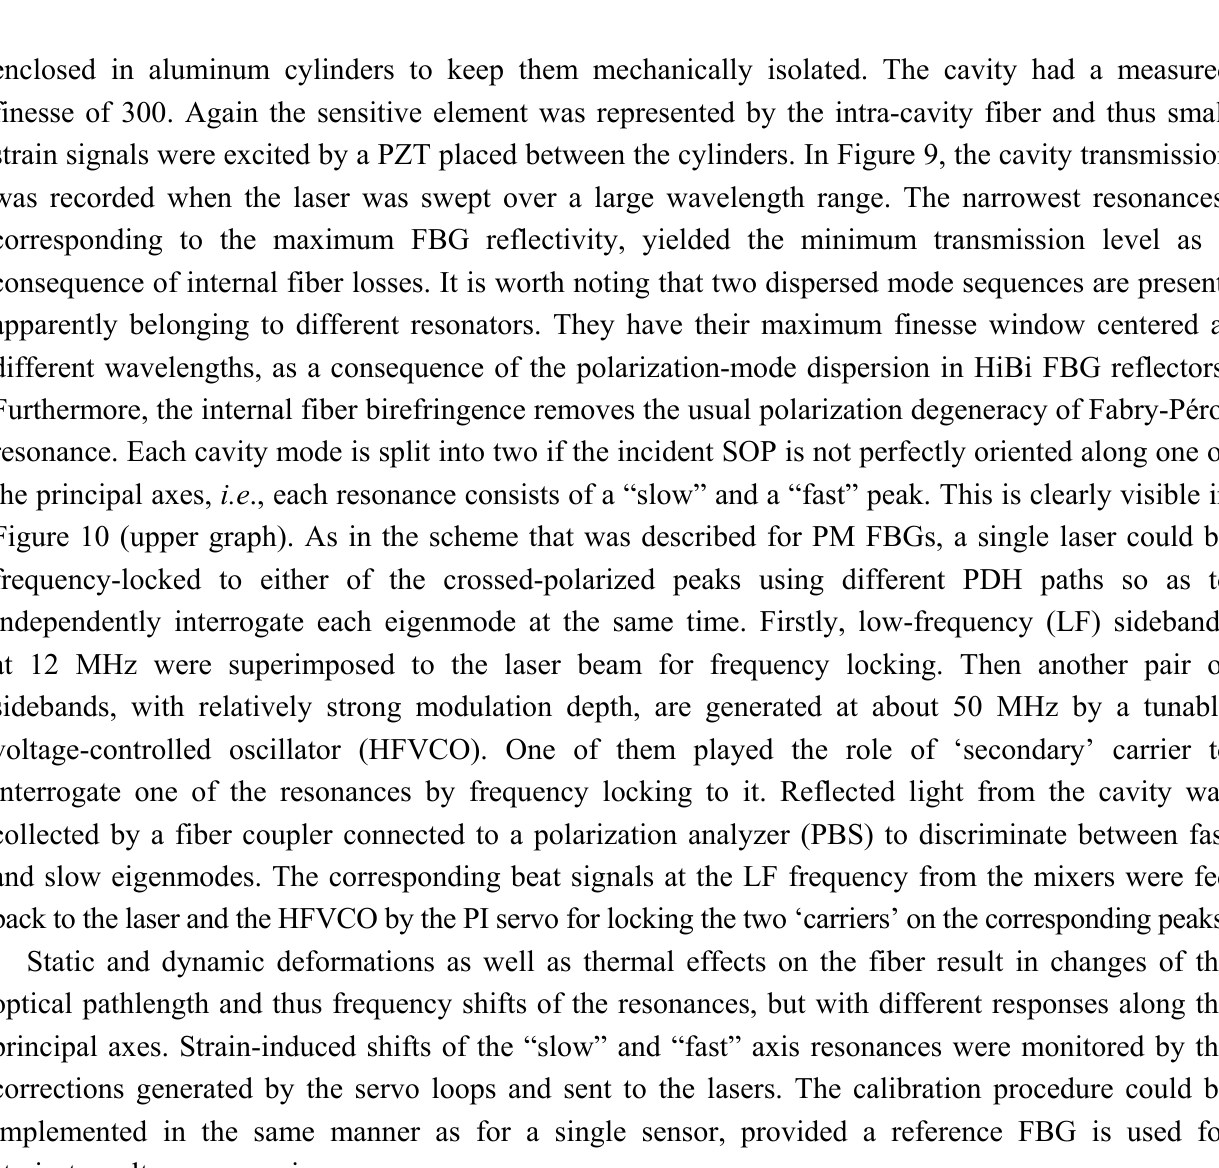
Figure 9. Transmission of the PM FBG resonator for a wide laser sweep (  0.2